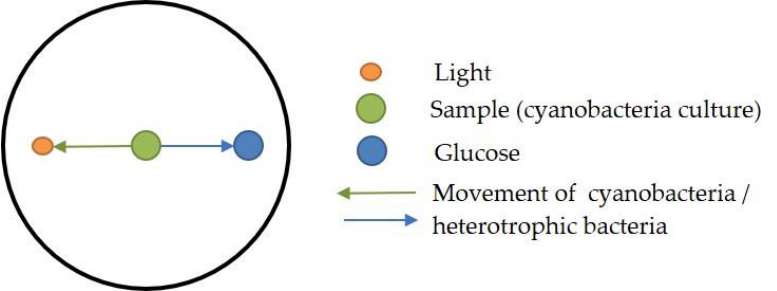
Figure 1. Agar-plate with the locations for sample (green) and glucose (blue) as well as the spot where light reaches the plate (orange) as well as the expected movement of cyanobacteria and heterotrophic bacteria (arrows).